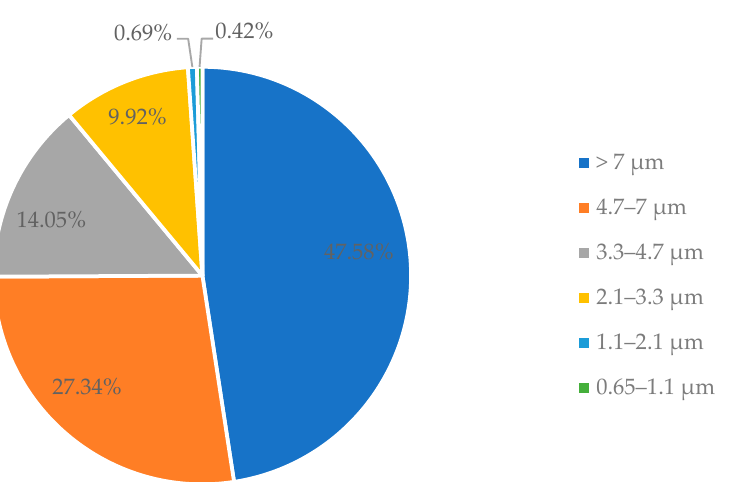
Figure 1. Size distribution of the airborne E. coli attached to dust particles in the airborne E. coli survivability test measured by an Andersen impactor.